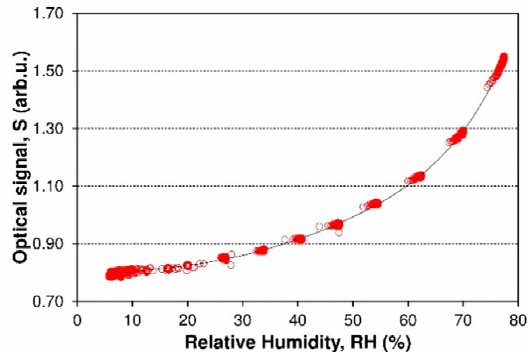
Figure 14. The calibration curve S = f ( RH ) of FPI sensor. The red measurement points show data, and the black solid line shows a non-linear fit for data.